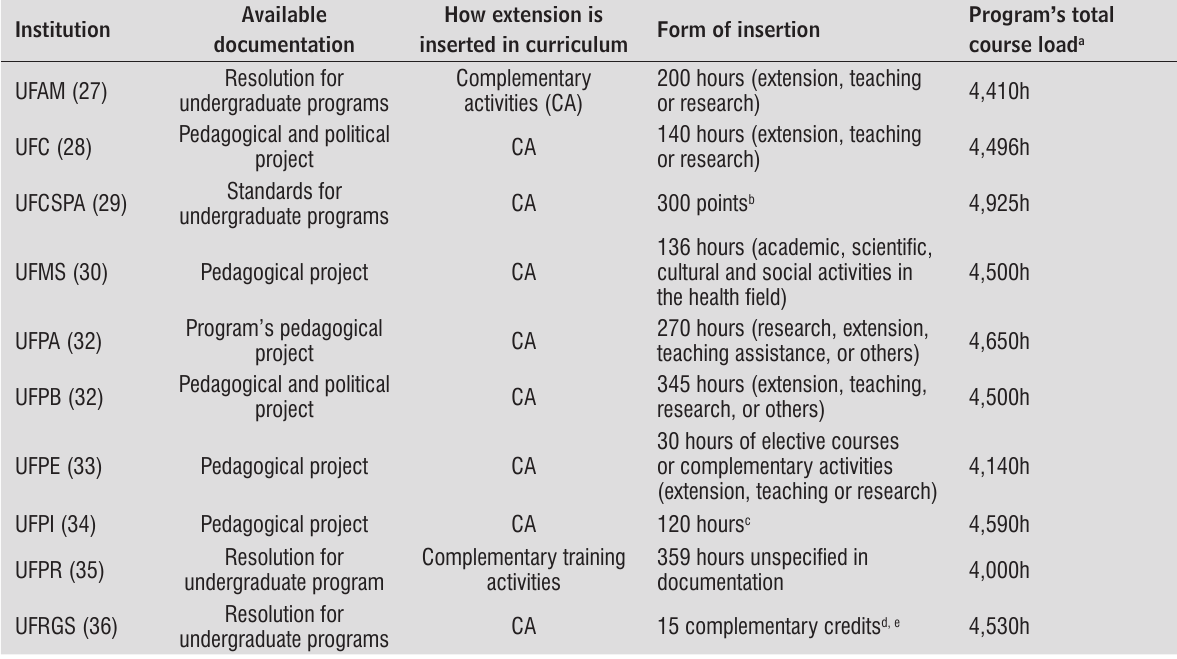
Table 2 - Distribution of federal institutions that offer physical therapy programs, type of documentation used, and how extension activities are inserted in the undergraduate